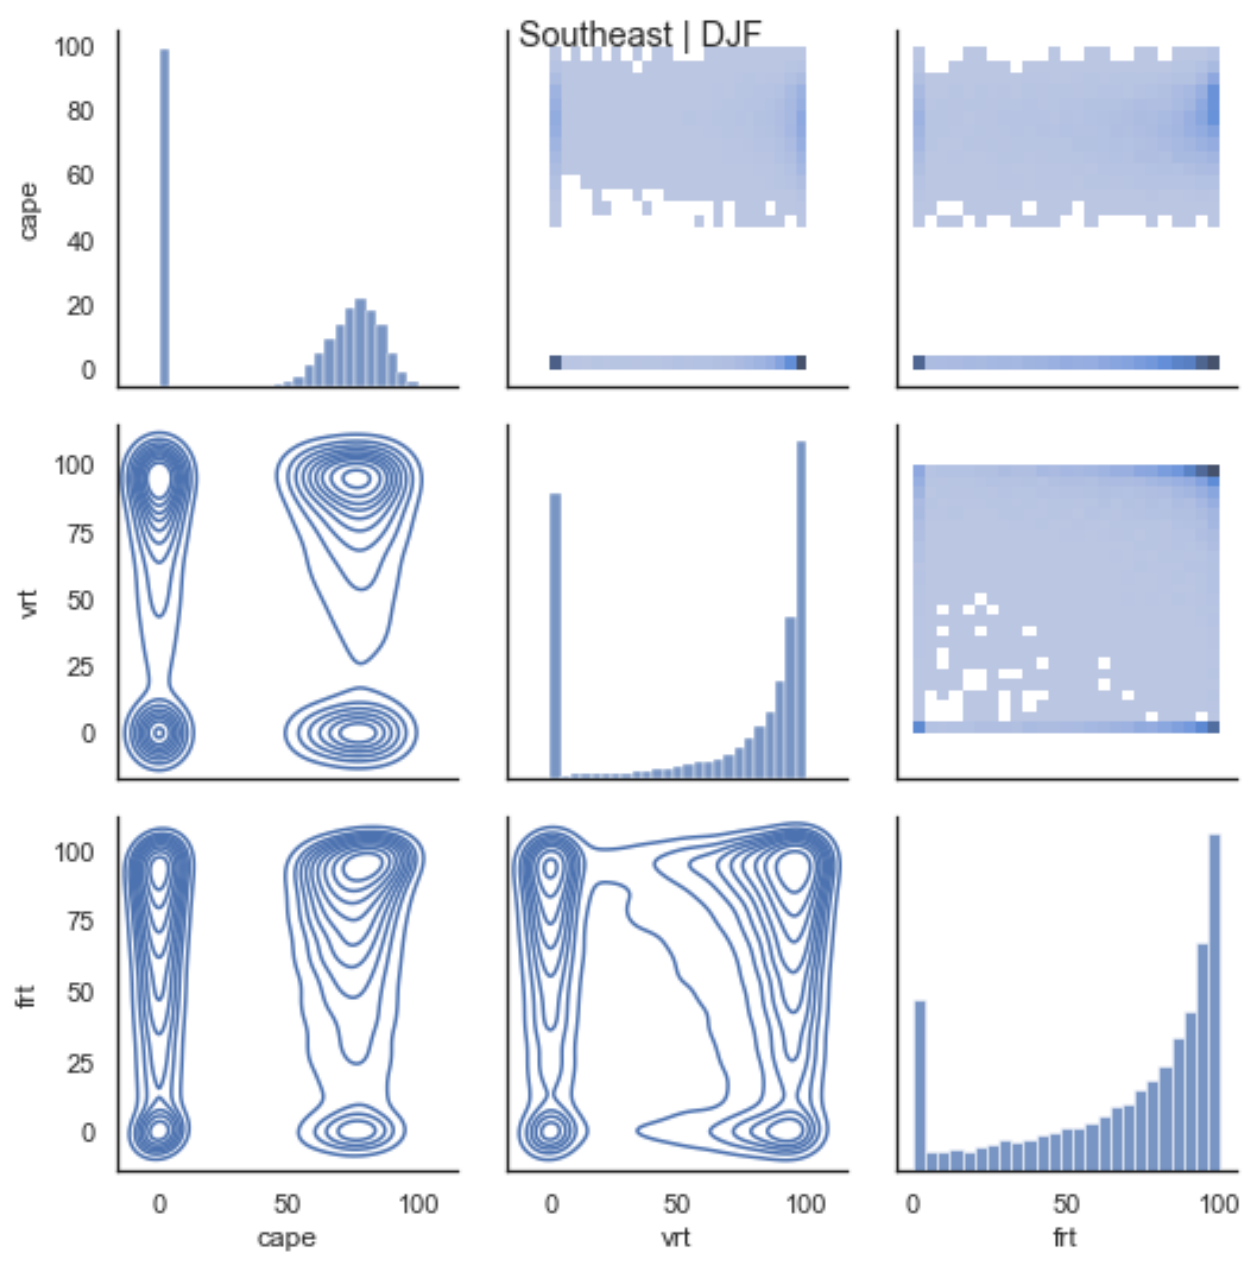
Figure 4. The plots along the diagonal are the univariate distribution of each of the three processes (Convection, Vorticity, and Frontal). The x -axis is the rank of the process and the y -axis is a density function over all events in the named region and season. The lower triangular panels show a kernel density plot of the two processes indicated on the corresponding x and y axis labels. The upper triangular panels show the same data as a bivariate